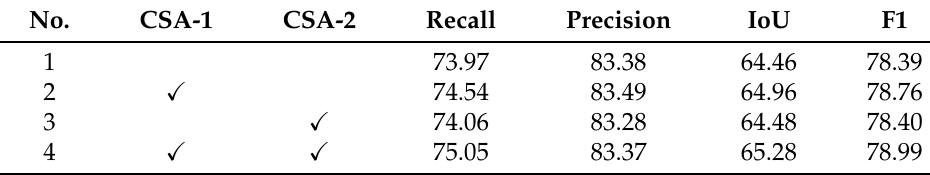
Table 4. Ablation study of the CSA module on the DeepGlobe